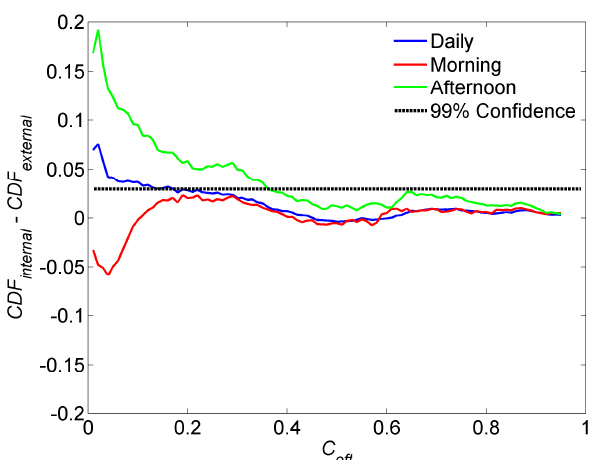
Figure 11. Absolute di ff erences of cumulative cloudiness probability for internal area ( CDF internal ) and external area ( CDF external ) along C ef f values for Serra da Mesa hydropower plant. The horizontal line represents the one-sided test bound V c at a 99% confidence level. The plot shows CDF differences exceeding the critical bound for (cid:1829) (cid:3032)(cid:3033)(cid:3033) up to 0.20 for daily averages, and up to 0.40 for afternoon averages. It indicates a higher frequency of lower Ceff values